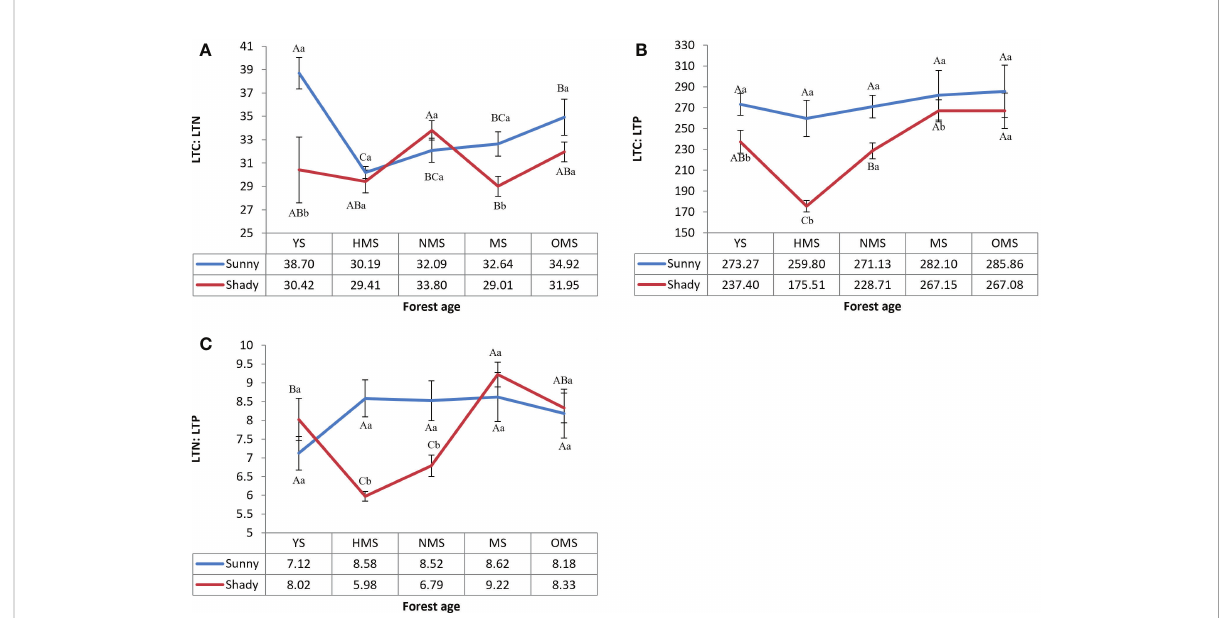
FIGURE 3 LTC : LTN of leaves (A) , LTC : LTP of leaves (B) , and LTN : LTP of leaves (C) . Different capital letters indicate signi fi cant differences in forest ages, and different lowercase letters indicate signi fi cant differences sites conditions ( p< 0.05). YS, Young stage; HMS, Half-mature stage; NMS, Near- mature stage; MS, Mature stage; OMS, Over-mature stage. Sunny, Sunny slope; Shady, Shady